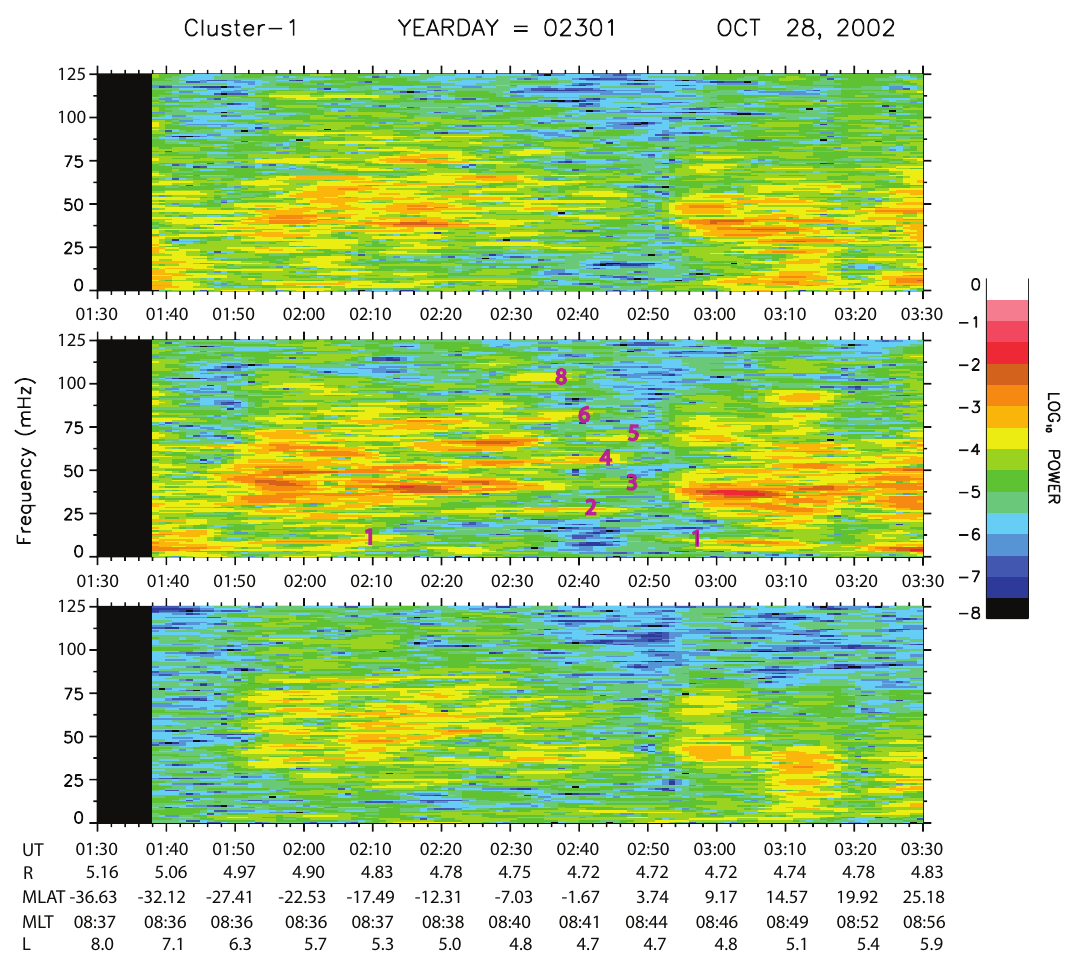
Fig. 2. Fourier spectrogram of differenced magnetic field data in field aligned coordinates for (bottom) parallel or compressional component ( ˆ z ), (middle) azimuthal or toroidal component ( ˆ y ∝ ˆ R ×ˆ z ), and (top) radial or poloidal component ( ˆ x = ˆ y ×ˆ z ). In the second panel, magenta numerals indicate the harmonic number with n = 1 for the fundamental, n = 2 for the second harmonic,